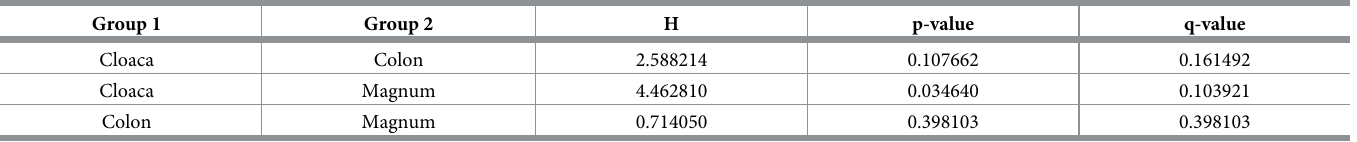
Table 2. Pairwise Kruskal-Wallis tests for Shannon’s index of each